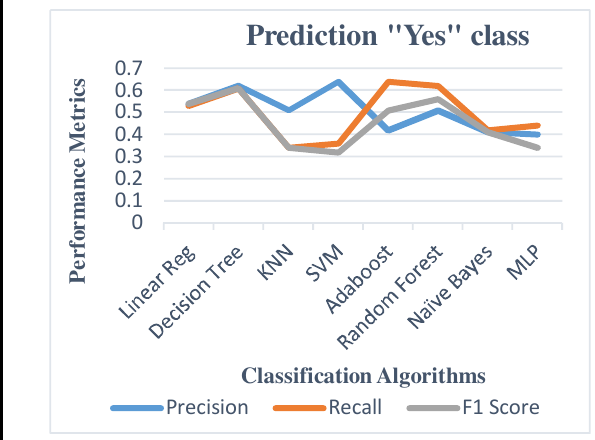
Fig. 4: Performance Metric for Yes class Table 1: Macro and weighted average of Precision, Recall and F1